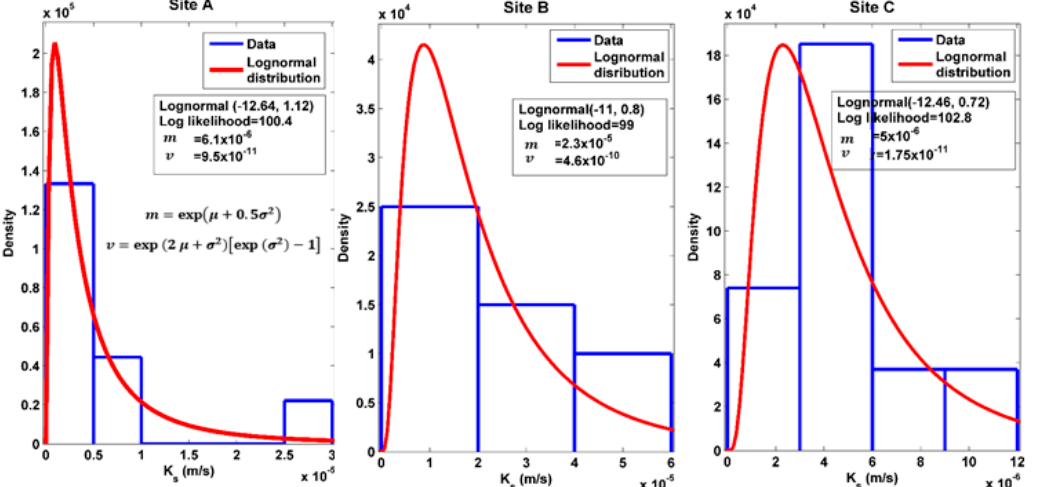
Figure A1. Density histogram and probability density function (PDF) of the log-normal distribution Lognormal ( µ , σ ) of K s values for sites A, B and C. With µ and σ the mean and standard deviation of the normal distribution of ln(K s ), and m and v the mean and the variance of the population.